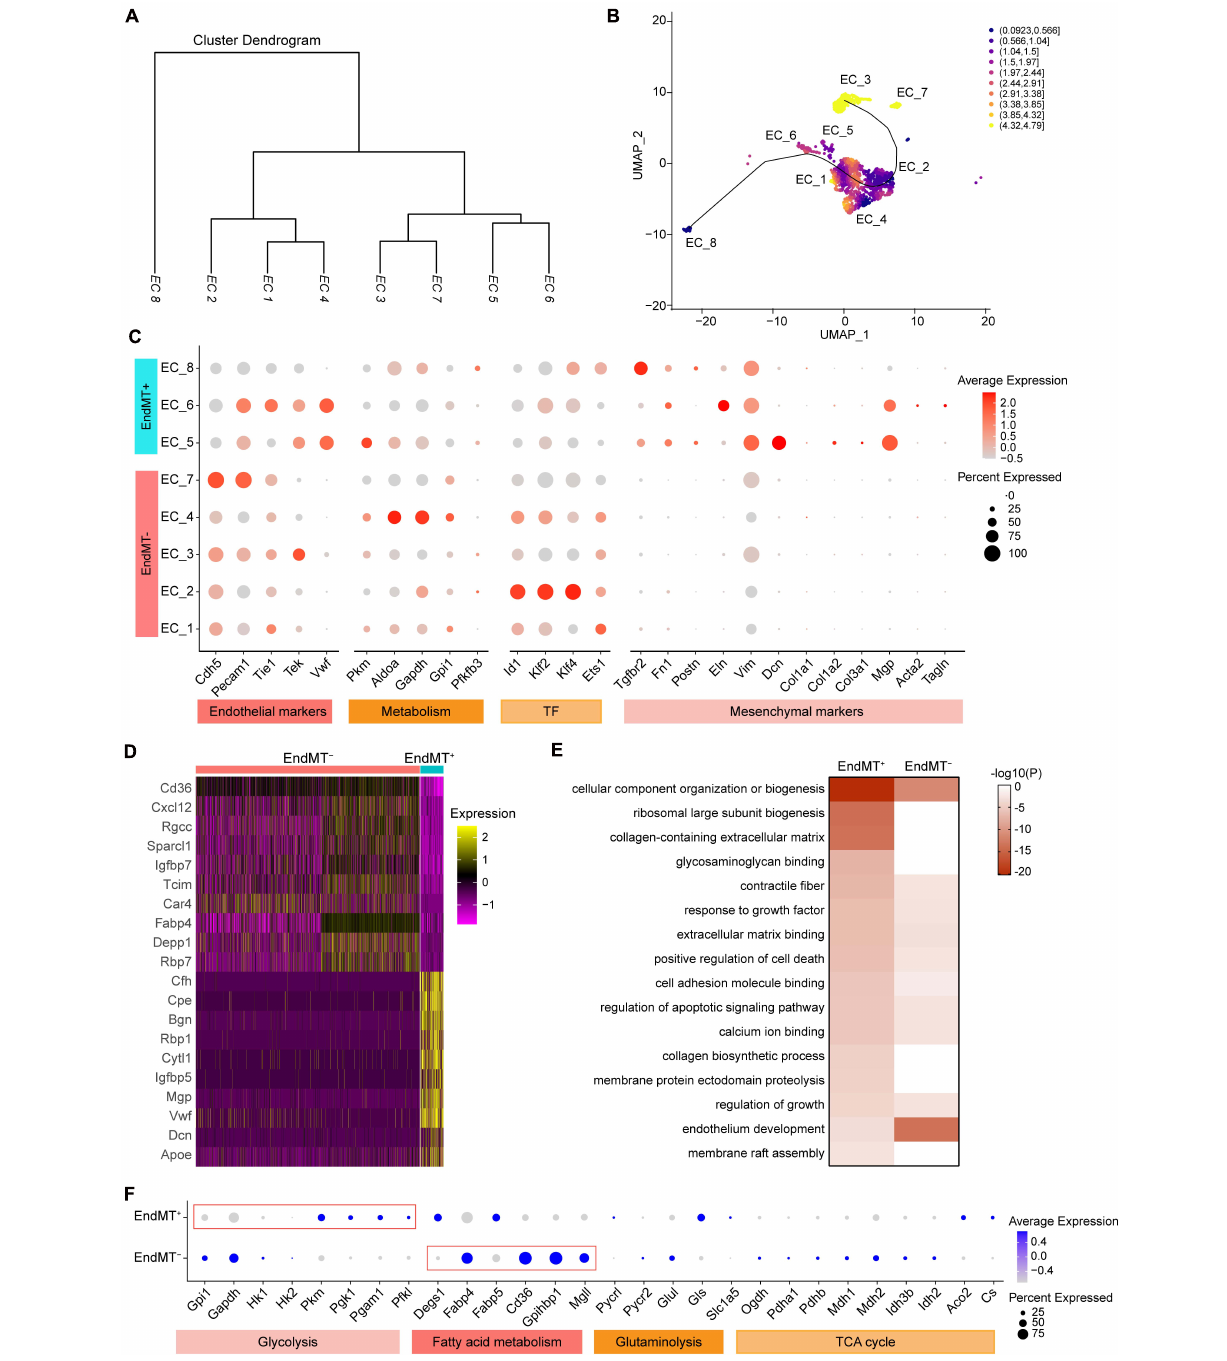
Frontiers in Cell and Developmental Biology |